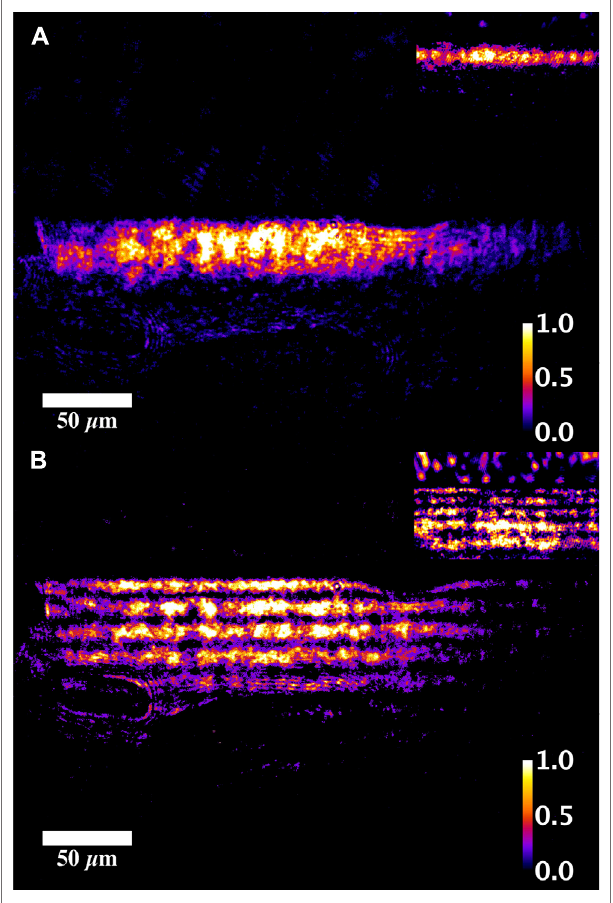
FIGURE 6 | nc-YSZ samples with planar waveguides after 24 h of annealing in